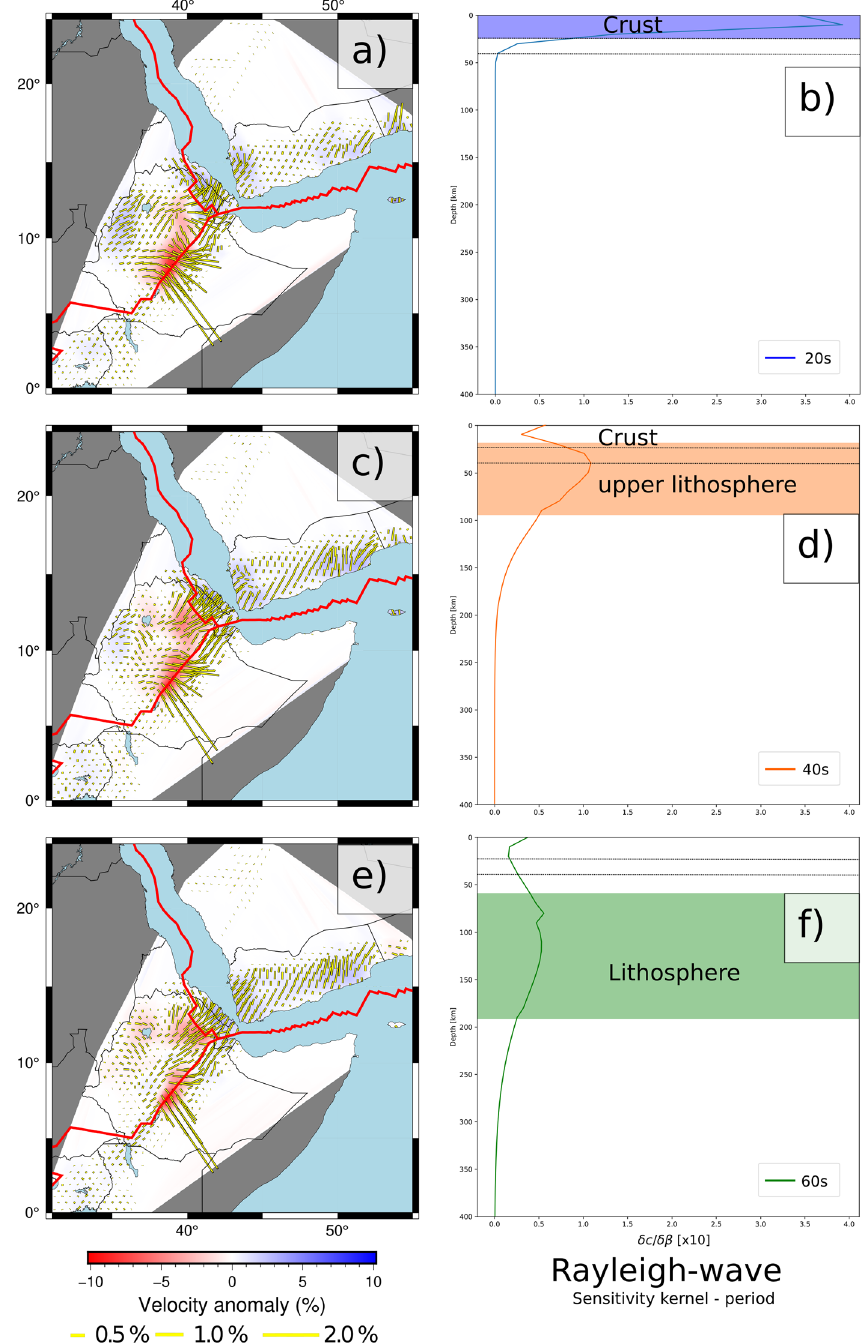
Figure 4. Isotropic and azimuthally anisotropic Rayleigh-wave phase velocity model at ( a ) 20s, ( c ) 40s and ( e ) 60s and corresponding sensitivity kernels ( b , d , f ). The colored rectangles indicate the regions with maximum sensitivity at each period respectively. Individual figure panels were generated with the Generic Mapping Tool (6.3.0) 51 and PyGMT (0.7.0) 52 . Individual figure panels were combined using Inkscape (1.2.1) 53